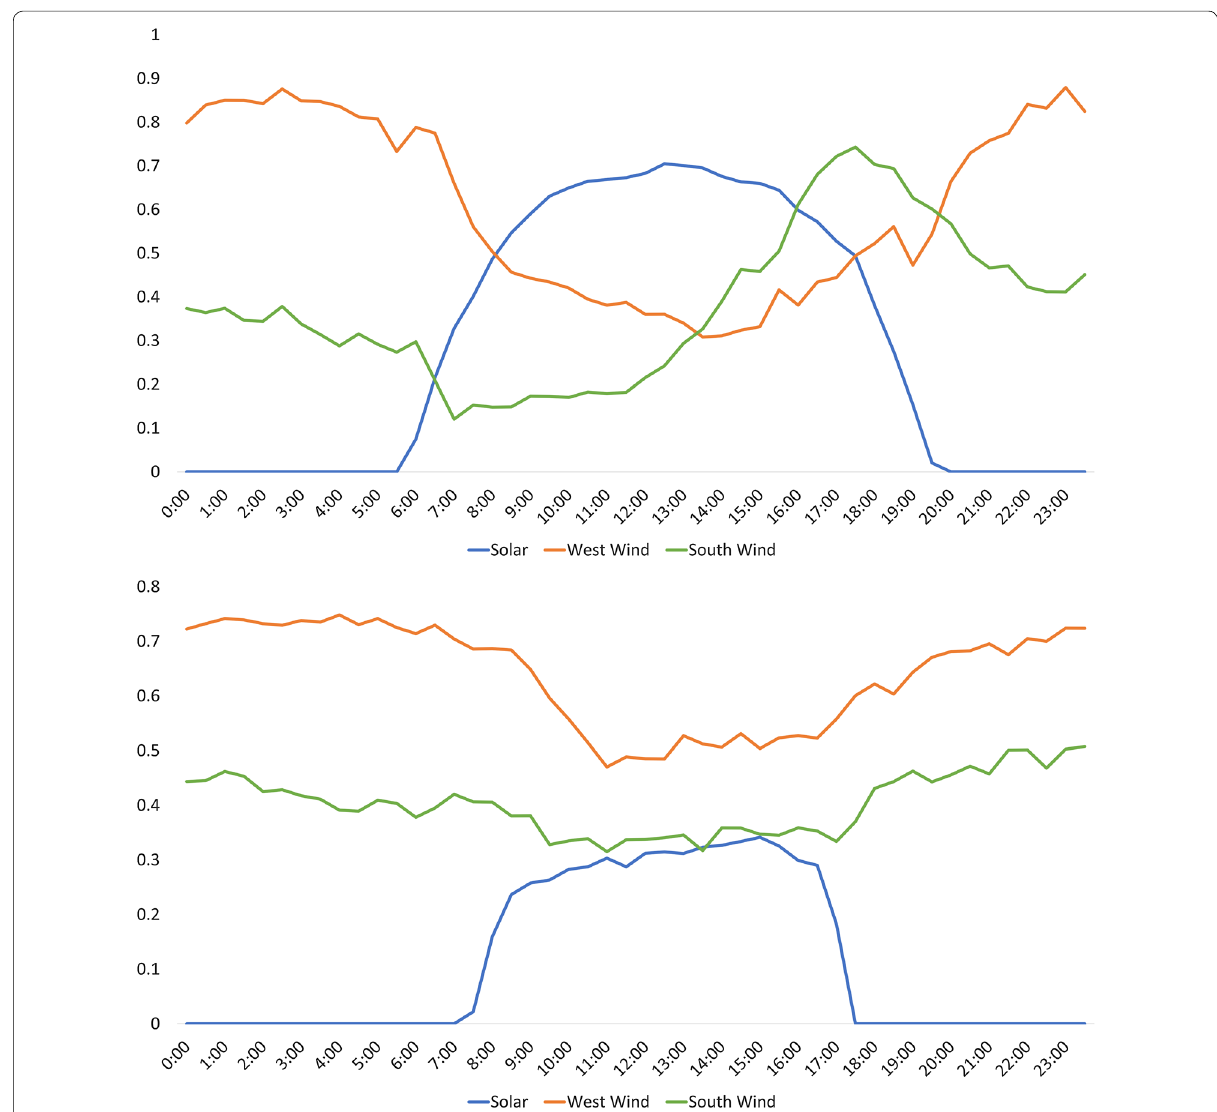
Fig. 5 Half-hour average capacity factor for each site, 2007–2013, on June 21 (top) and December 21